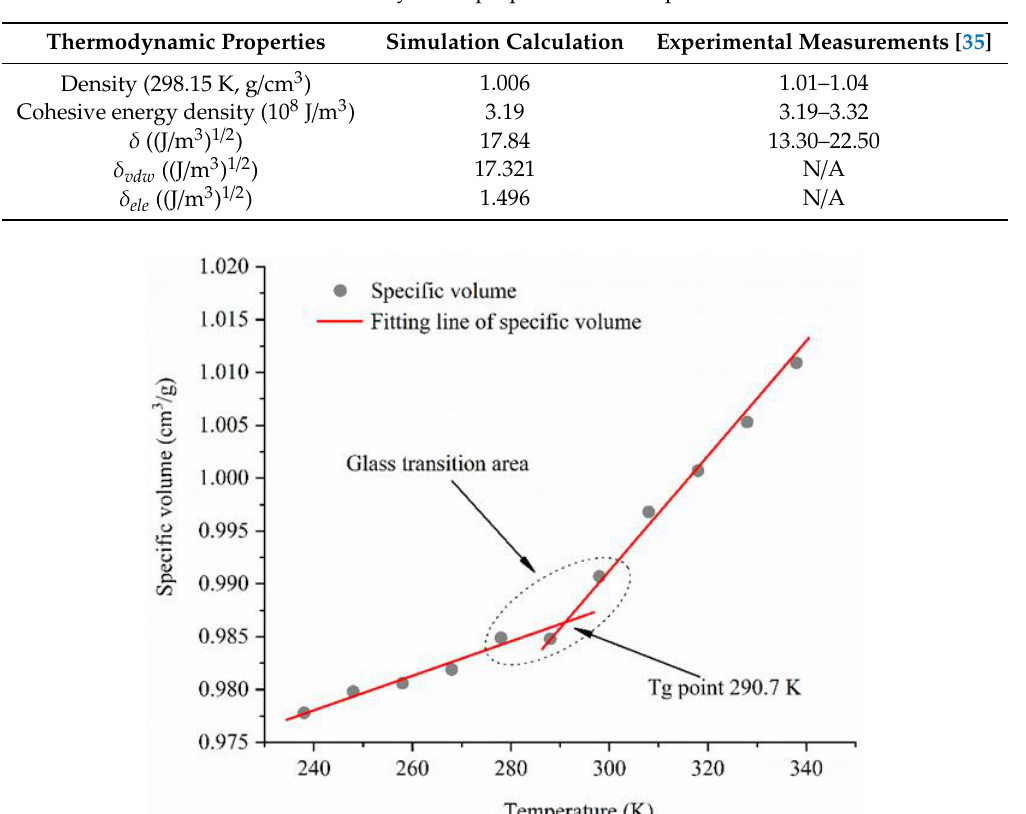
Table 2. Thermodynamic properties of the asphalt model.